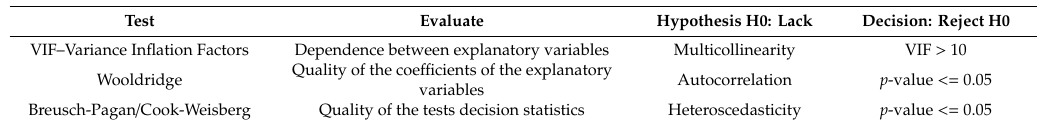
Table 5. Diagnostic tests.